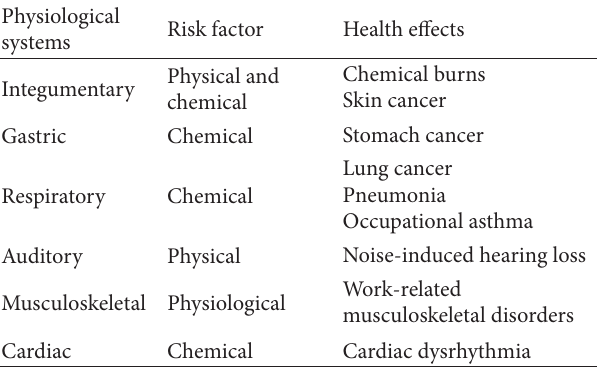
Table1:Physiologicalsystems,riskfactors,andhealtheffectsduring welding